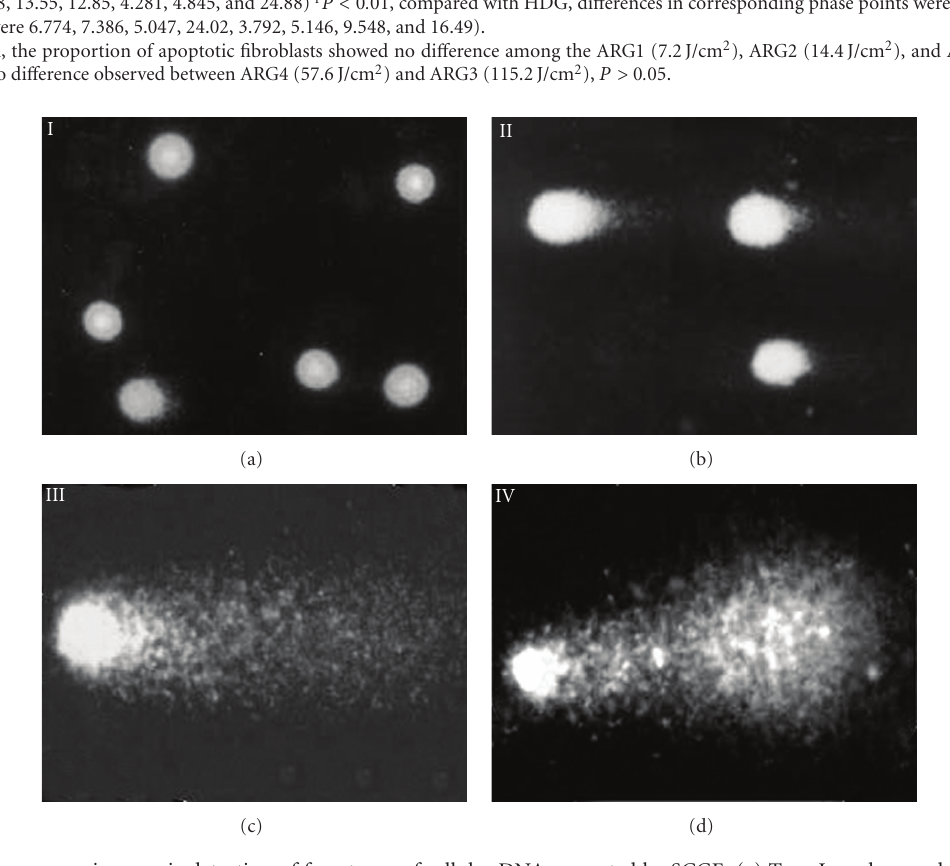
Figure 6: Fluorescence microscopic detection of four types of cellular DNA separated by SCGE. (a) Type I: undamaged, with no obvious tail; (b) type II: with a tail shorter than the diameter of the head (nucleus); (c) type III: with a tail longer but less wider than the diameter